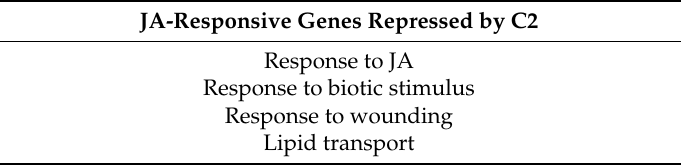
Table 1. Over-represented GO categories (biological function ontology) in the subset of JA-responsive genes repressed by C2 in basal conditions.